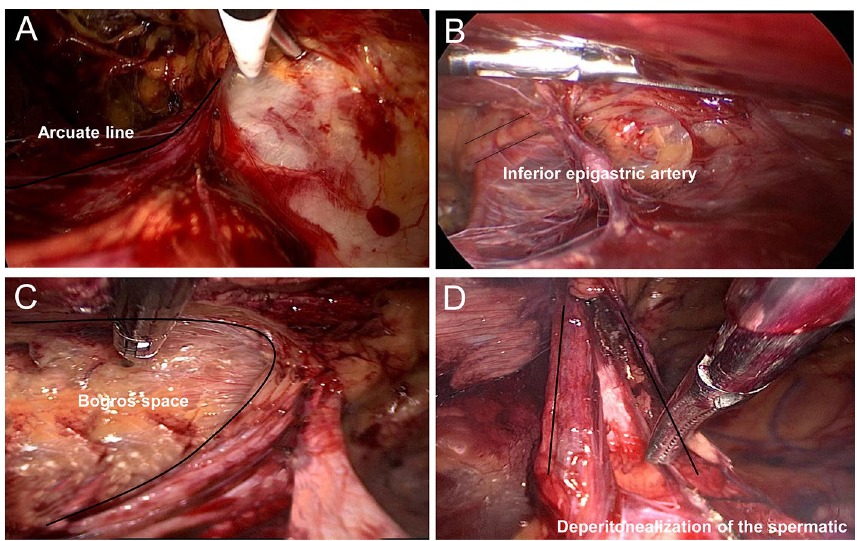
Figure 1. Important anatomical landmarks within each space of the "Programmed Spatial Anatomy of the Myopectineal orifice Region." ( A ) The lower edge of the arcuate line; ( B ) the inferior epigastric artery; ( C ) the Bogros space; ( D ) the spermatic cord after